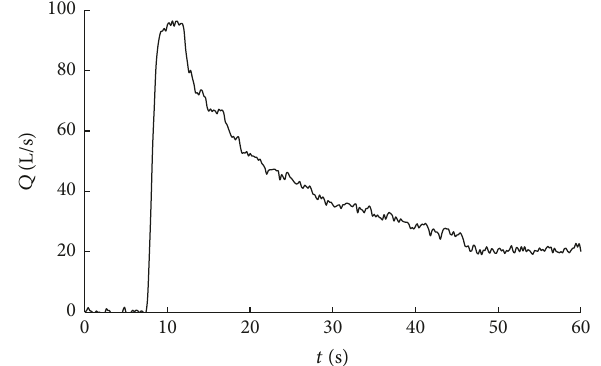
Figure 4: Inflow boundary conditions for upstream.